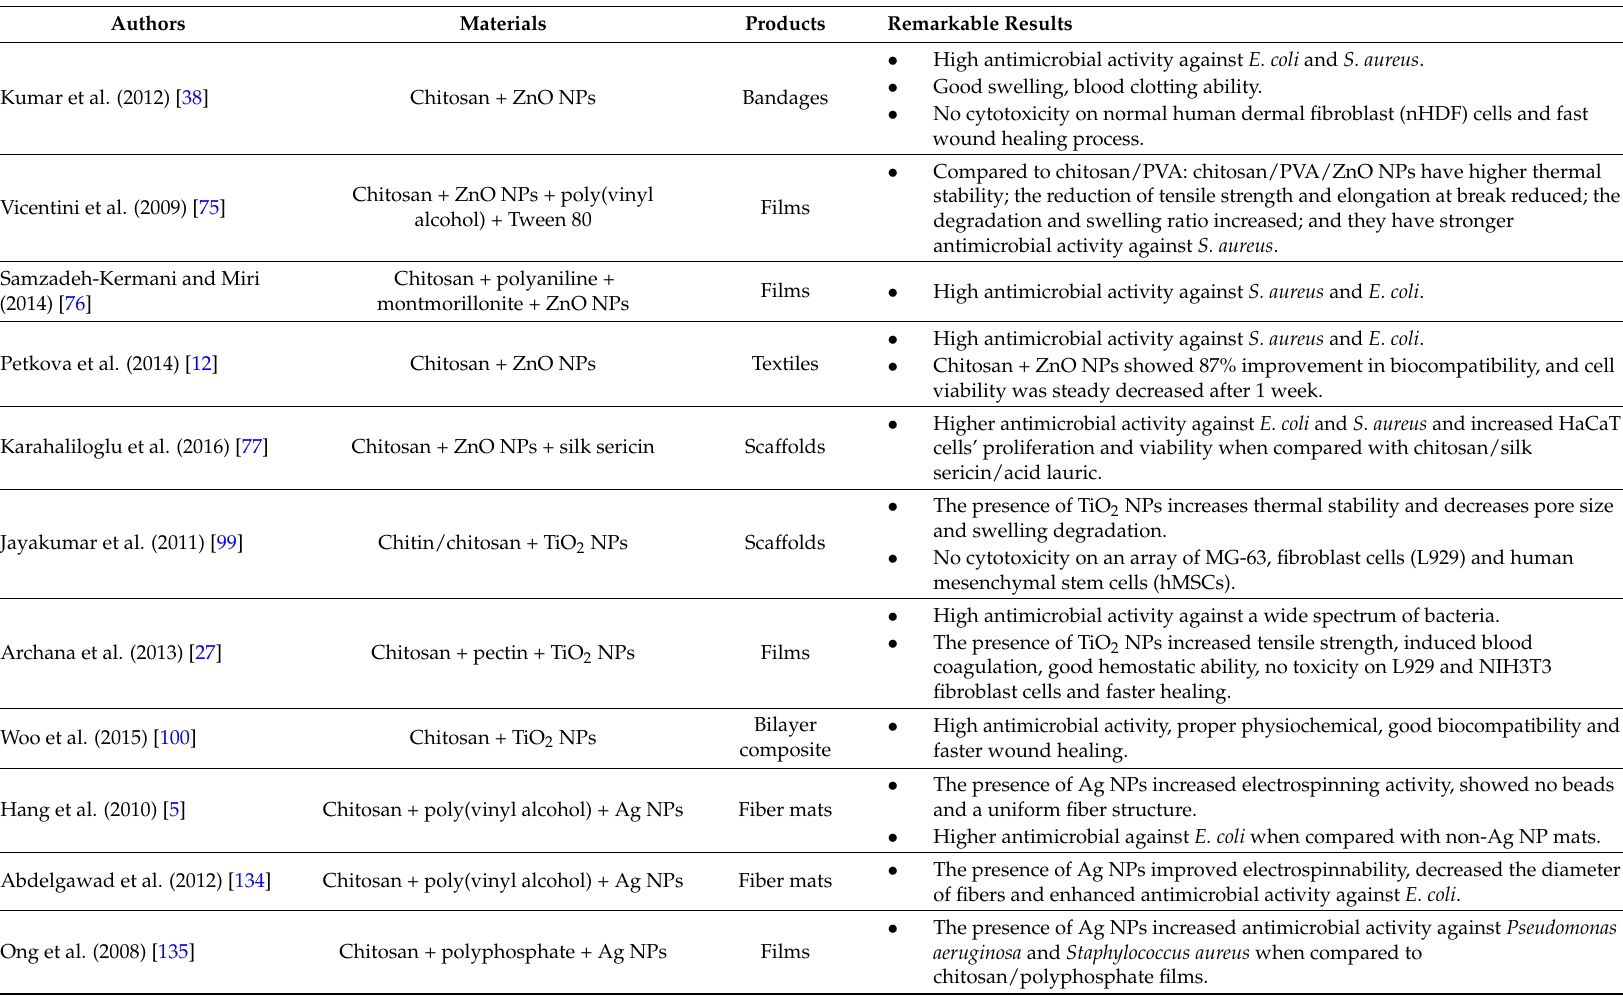
Table 1. Summary of chitosan combined with ZnO, TiO 2 and Ag NPs for antimicrobial wound healing